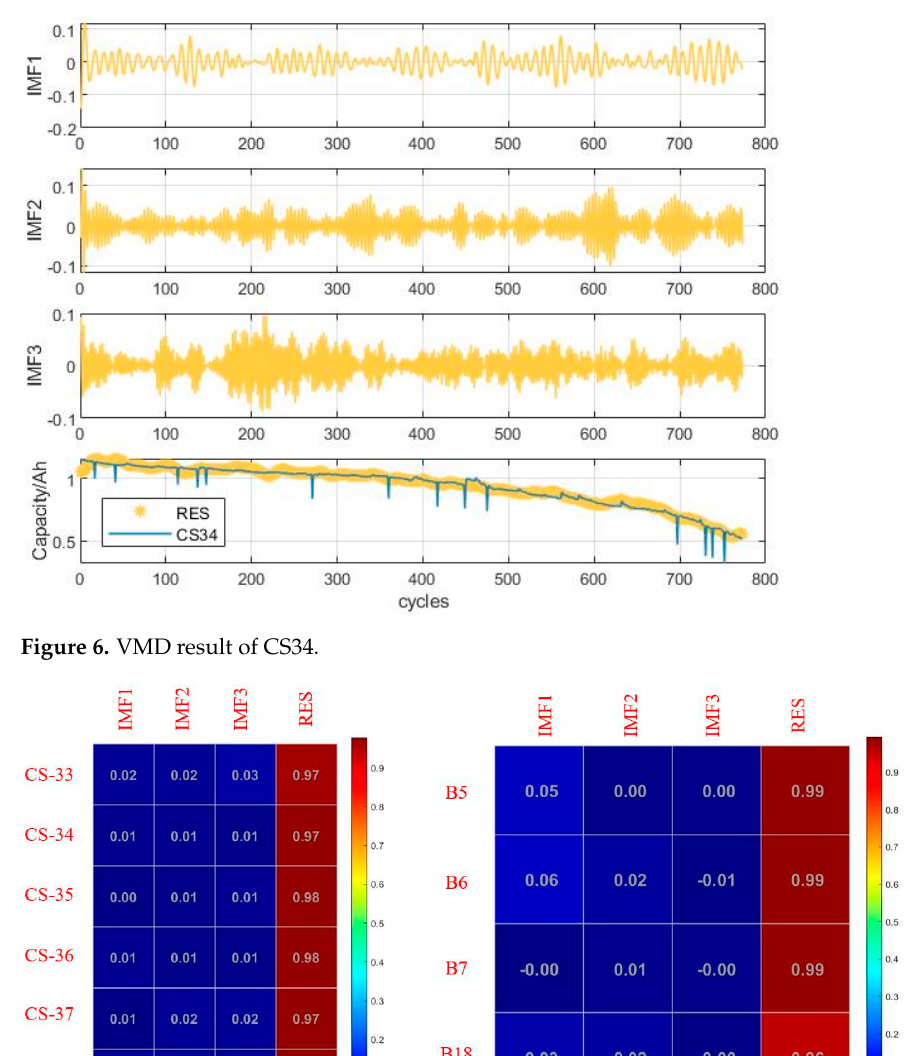
Figure 5. VMD result of B5.